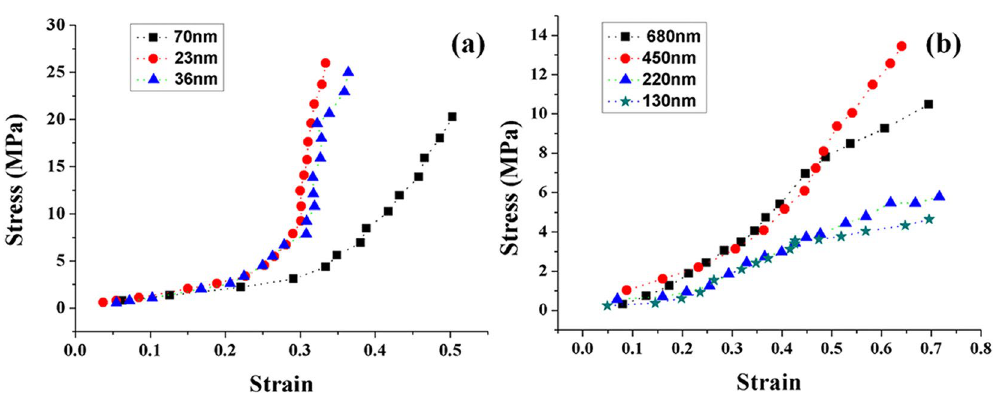
Figure 4. Stress-strain curves at different scales. ( a ) The stress-strain relationships of 996 kD PMMA at 23 nm, 36 nm, and 70 nm scales. ( b ) The stress-strain curves of 996 kD PMMA at 130 nm, 220 nm, 450 nm, and 680 nm